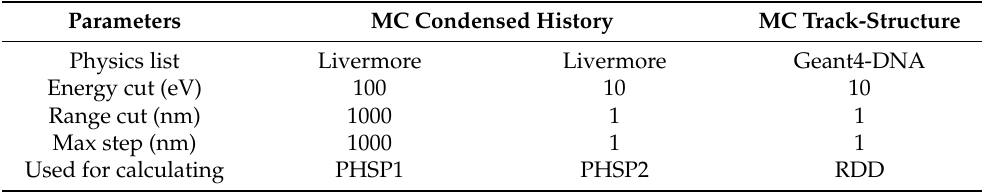
Table 1. Parameter values for each simulation performed at the physical stage. Parameters MC Condensed History MC Track-Structure Physics list Livermore Livermore